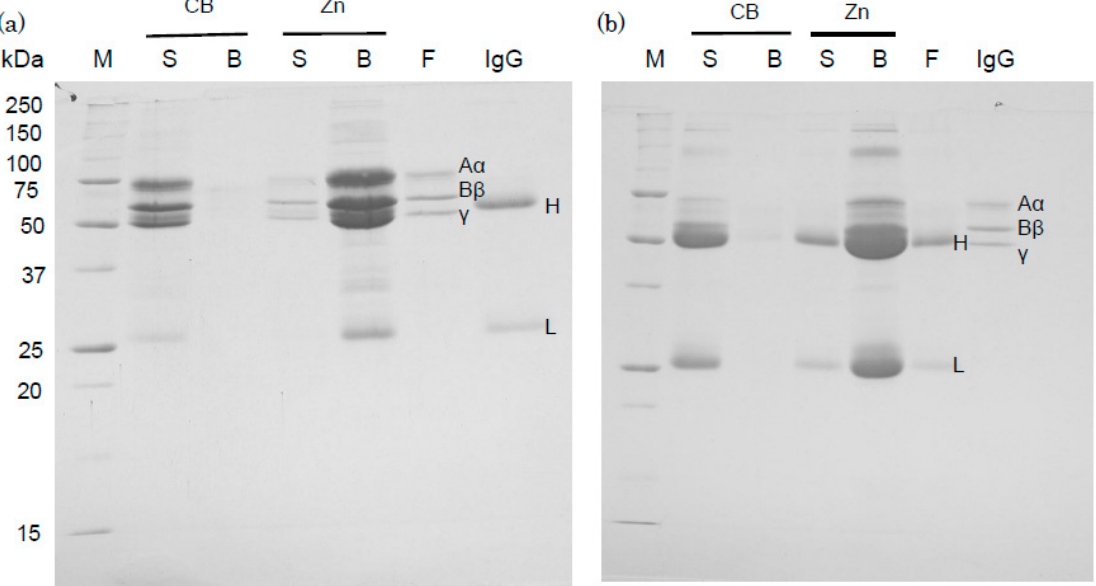
Figure 4. Binding of human IgG and fibrinogen to Zn-beads which were saturated with fibrinogen and IgG, respectively. After binding of human fibrinogen (600 µg) or IgG (500 µg) to Zn-beads or CB (net volume of beads per sample: 20 µL each), aliquots (20 µL) of human IgG (100 µg) or fibrinogen (100 µg) in PBS were added to protein-saturated Zn-beads and incubated with: fibrinogen in ( a ) and IgG in ( b ). As described in the “Experimental Section”, the supernatant (S) and bead samples (B) obtained after centrifugation were subjected to SDS-PAGE. Human fibrinogen (F) and IgG samples were also applied (2 µg/lane). Their separated subunit bands derive from fibrinogen (Aα, Bβ and γ) and IgG (H and L). M represents marker proteins.